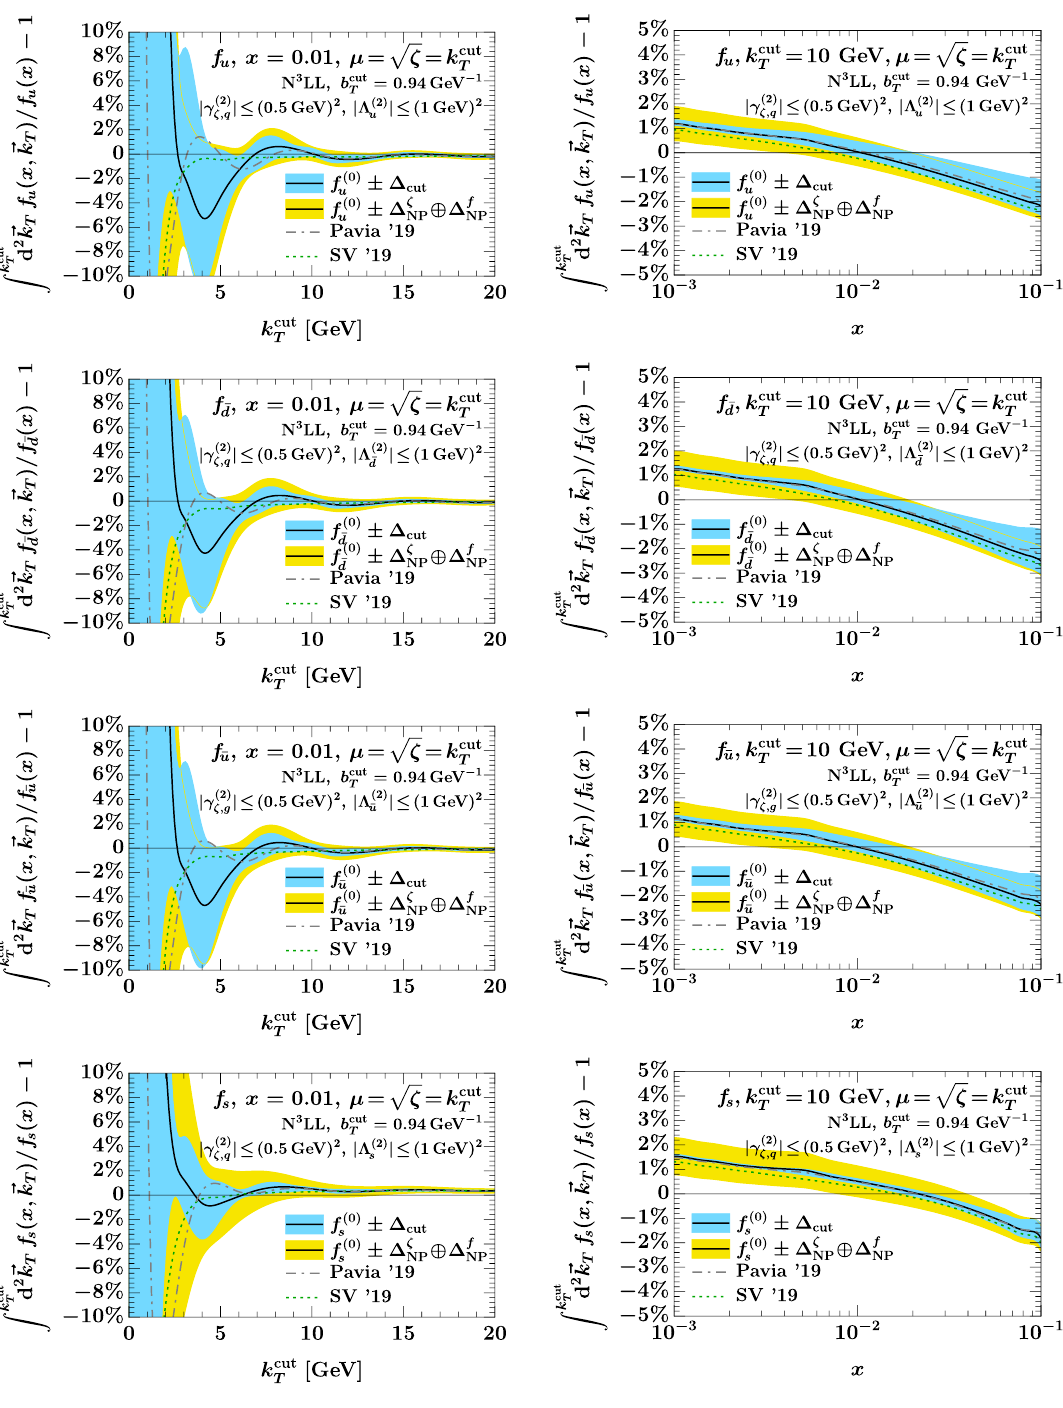
Figure 12 . Same as figure 6, for i = u, ¯ d, ¯ u, s